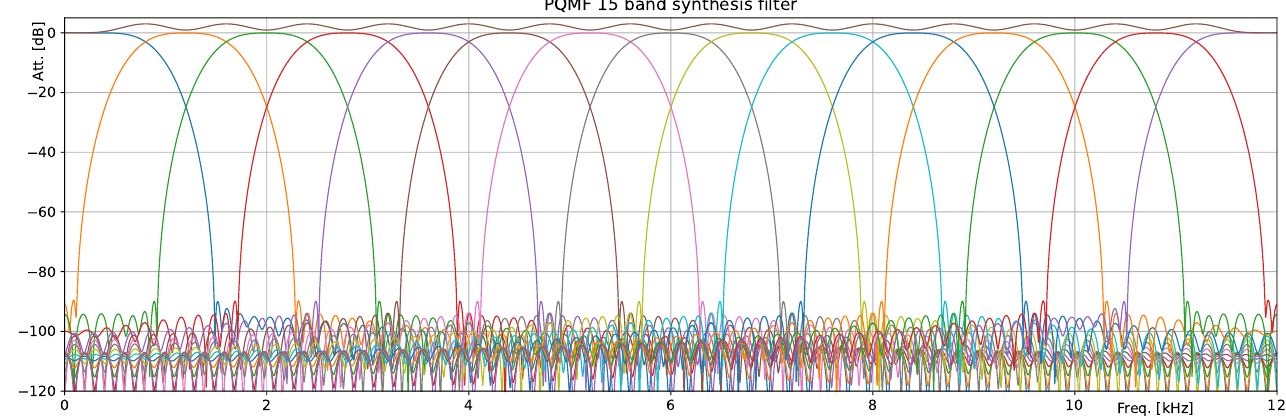
Figure 2. The 15-band PQMF filter transfer function used in the study. The figure shows the individual filter transfer functions and the sum of all individual transfer functions (the sum is in